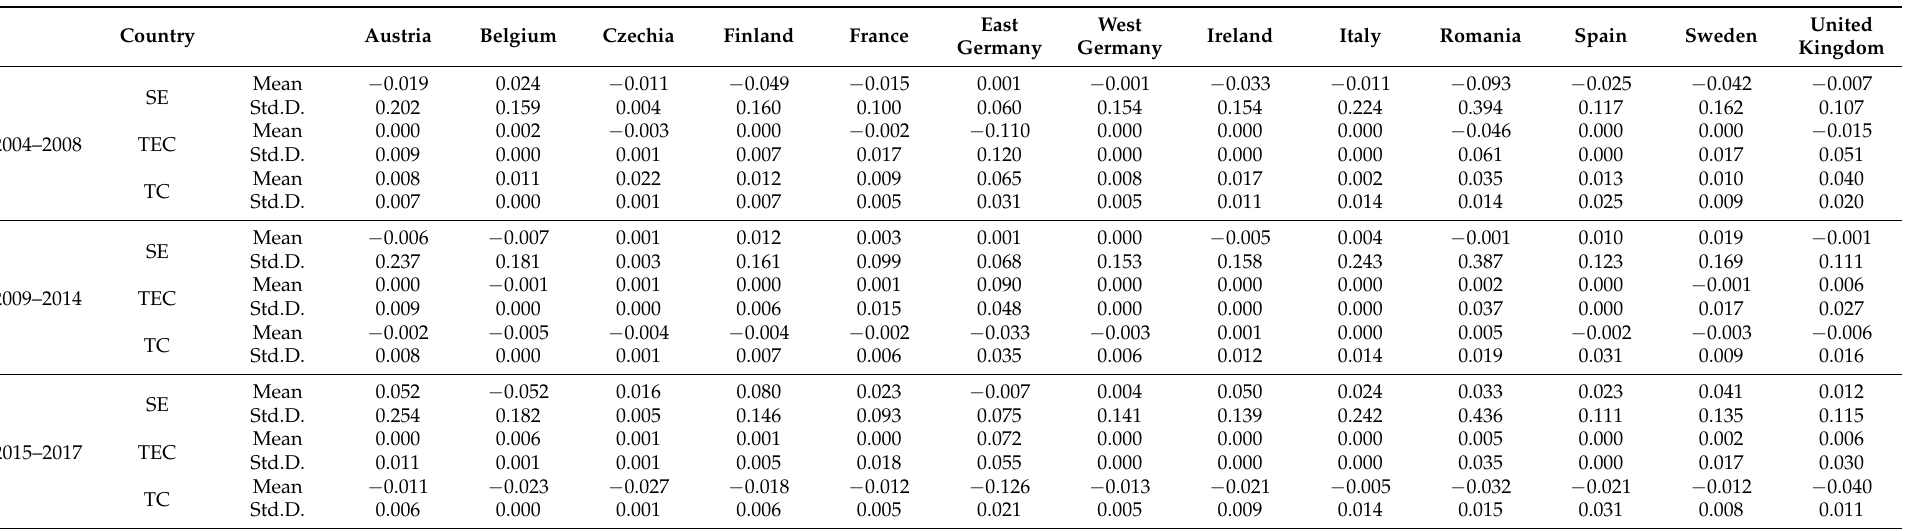
Table 6. Decomposition of TFP. Source: own